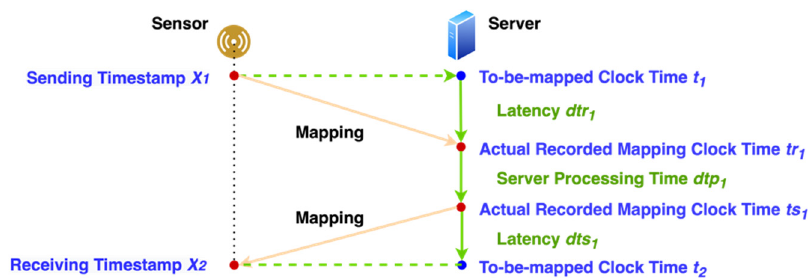
Figure 9. Mapping between sensor device local timestamp and server clock time.